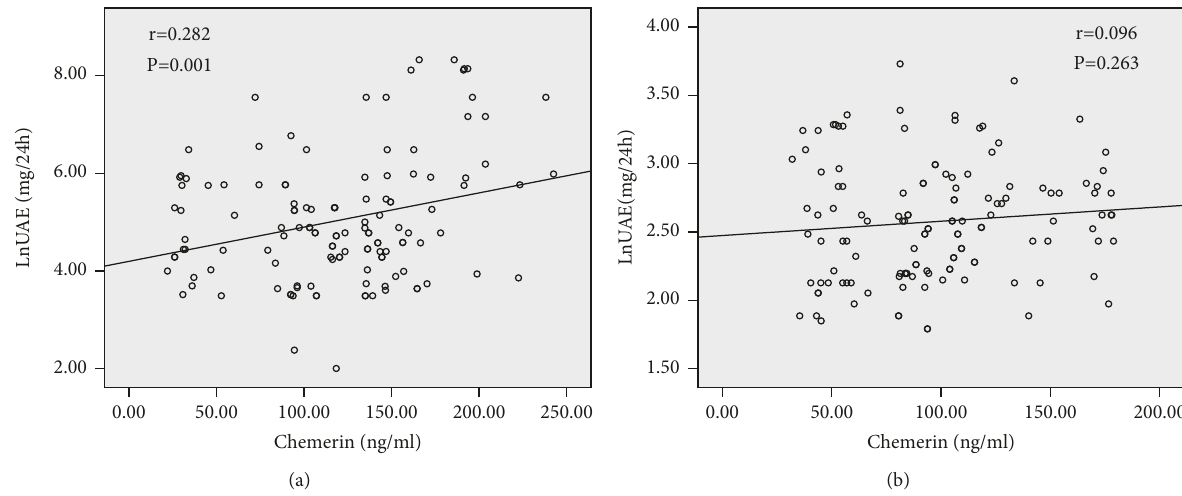
Figure 3: Scatter plot showing the correlation between plasma chemerin levels and urinary albumin excretion (UAE) in patients with (a) and without nephropathy (b) . Scatter plot with regression line showing the positive relationship between chemerin levels and UAE only in patient with nephropathy, not patient without nephropathy. Solid lines indicate regression lines. Pearson correlation was calculated in the correlation analyses.